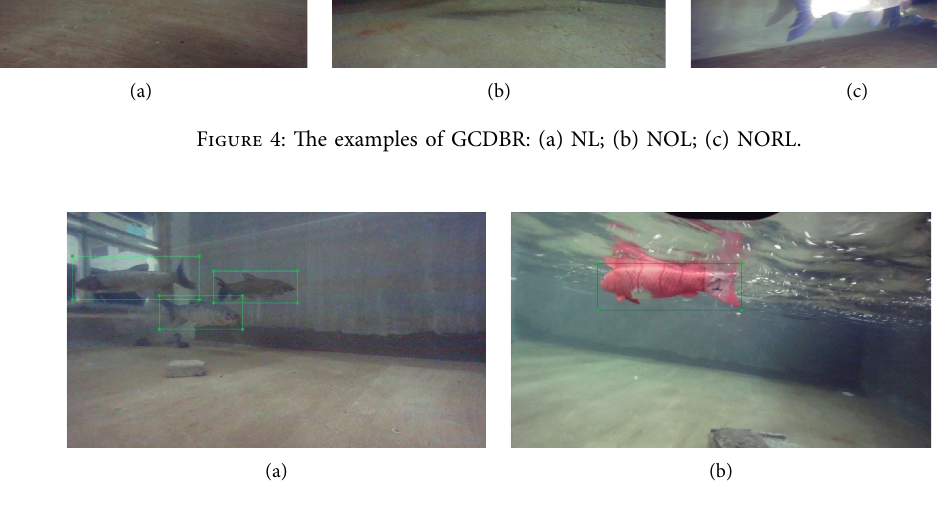
Figure 5: Example images within the labelled dataset: (a) grass carp; (b) robot